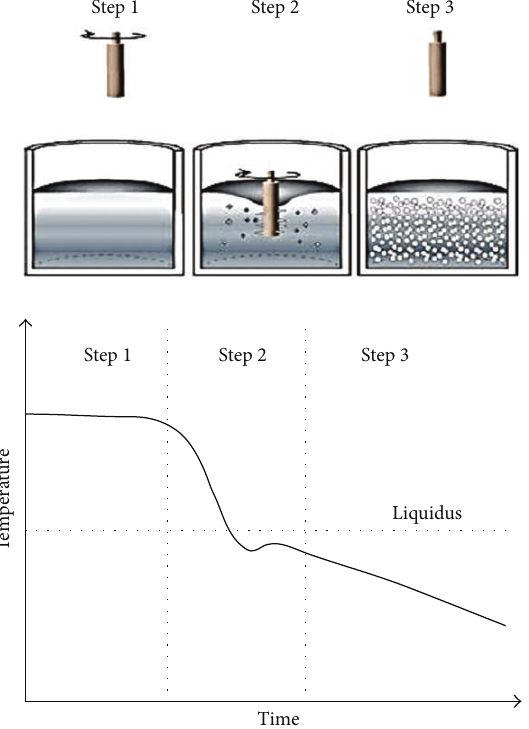
Figure 16: Illustration of the steps of the New MIT process [40].